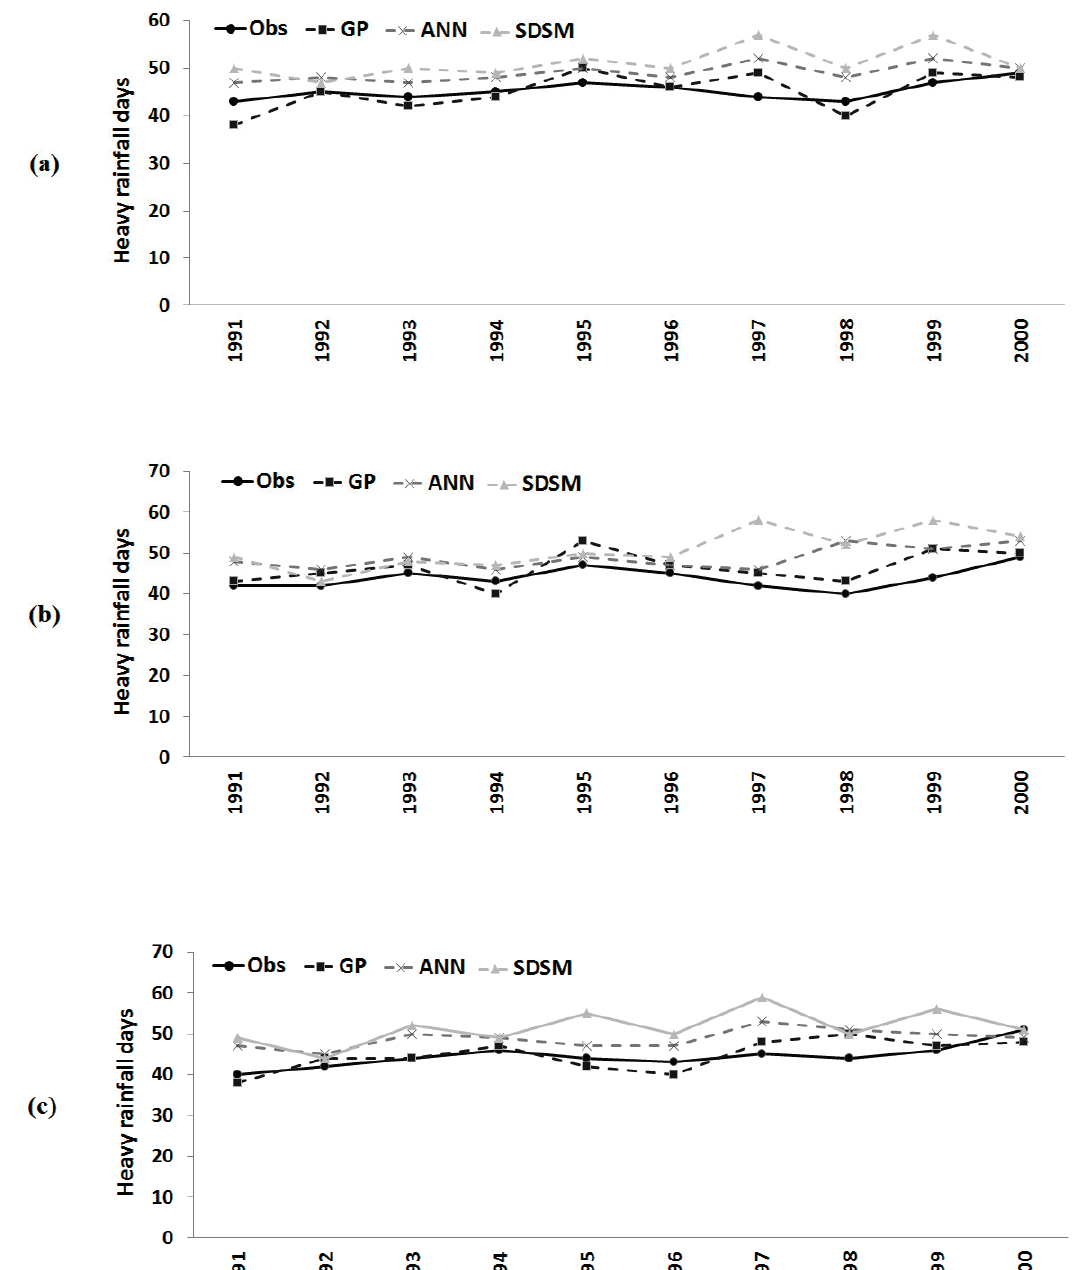
and the statistical downscaling model (SDSM) during model validation at: ( a ) Besut; ( b ) Dungun; and ( c )